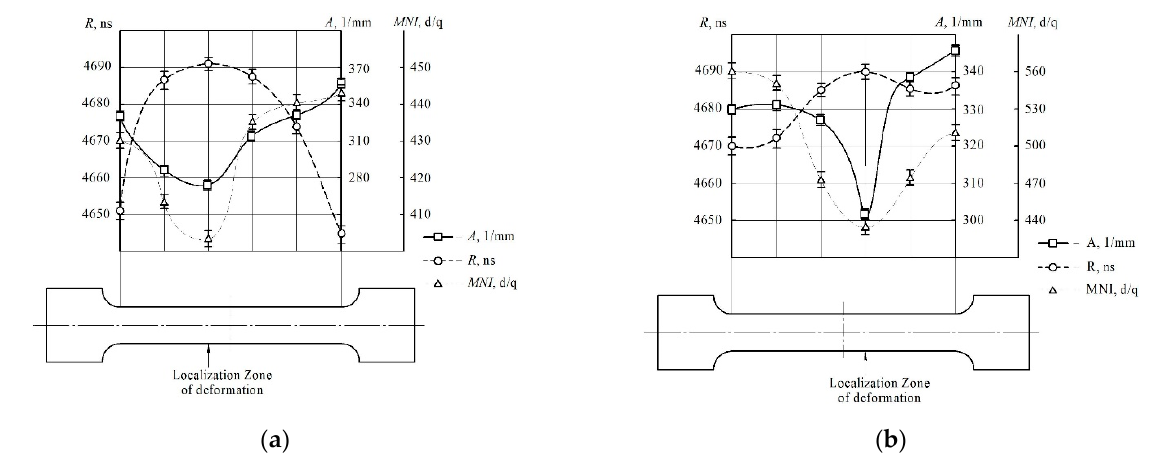
Figure 15. Change in acoustic and magnetic characteristics along the surface of the investigated specimens of heat resistant 0.12C-1Cr-1Mo-1V steel: ( a )—initial state; ( b )—after operation without destruction.